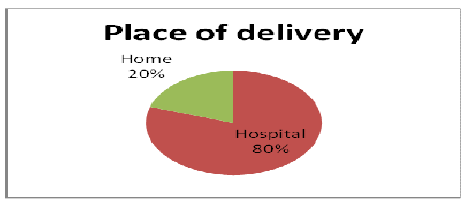
Fig 2: Distrtibution of place of delivery of respondents Table 1: Distribution of Socio demographic variables of